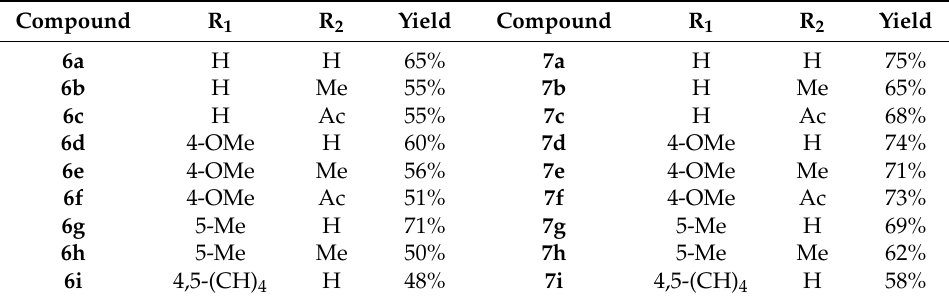
Table 4. The yields and structures of target compounds 6 and 7